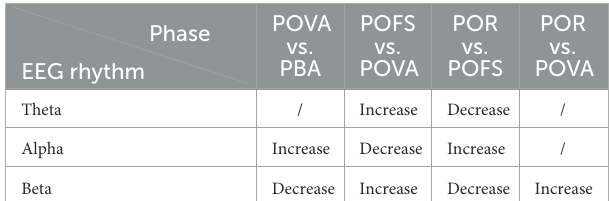
TABLE 1 The trends of the relative power of EEG rhythms in selected channels between phases.